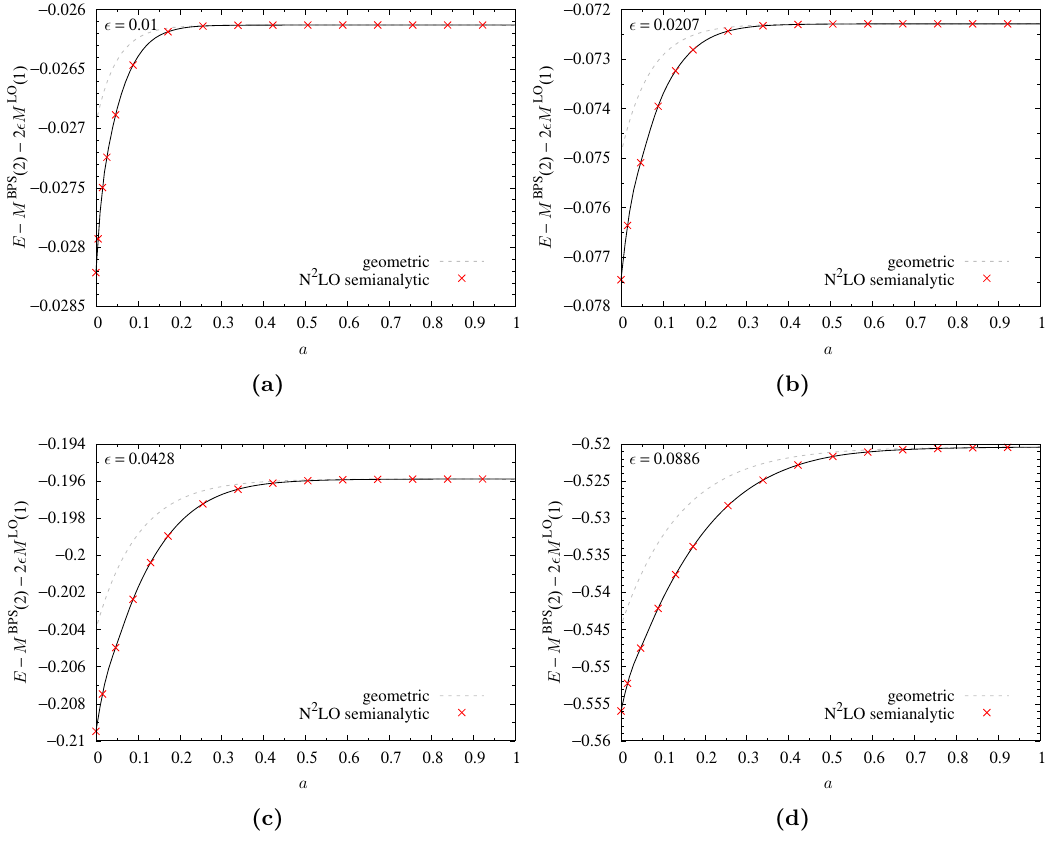
Figure 19 . The N 2 LO corrections to the energy for two N = 1 baby Skyrmions as a function of the separation distance 2 a , see figure 12. The panels correspond to different values of (cid:15) : (a) (cid:15) = 0 . 01 , (b) (cid:15) = 0 . 0207 , (c) (cid:15) = 0 . 0428 and (d) (cid:15) = 0 . 0886 . The gray-dashed line is calculated as the geometric cut at x = 0 of the spherically symmetric compacton energy. The red crosses show the results of the N 2 LO contribution to the energy from the PDE calculation of δf and δθ . The black line is a cubic interpolation between the PDE